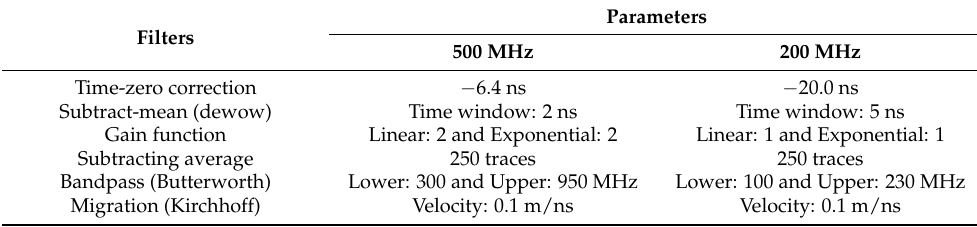
Table 3. Filters and settings used for GPR data